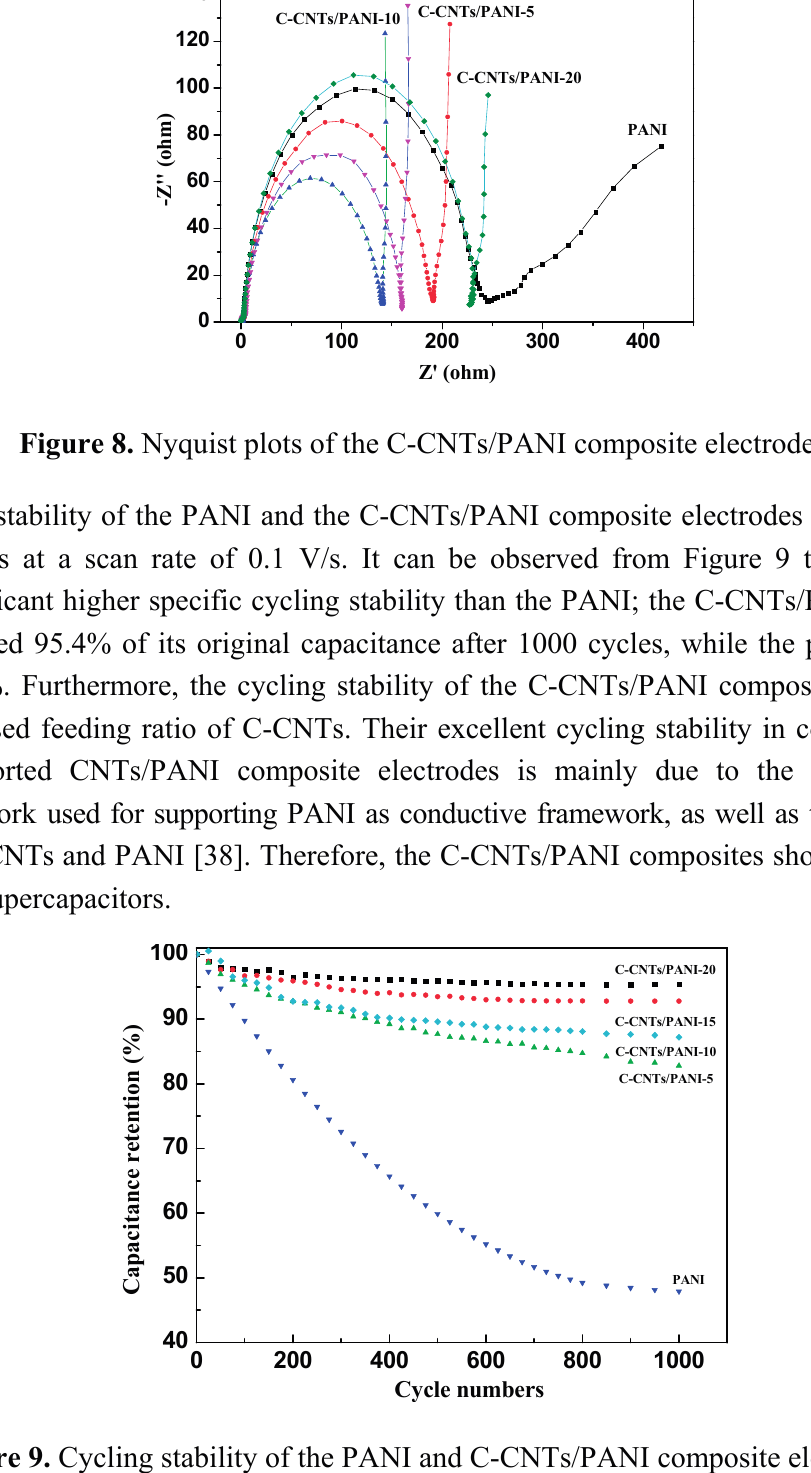
Figure 9. Cycling stability of the PANI and C-CNTs/PANI composite